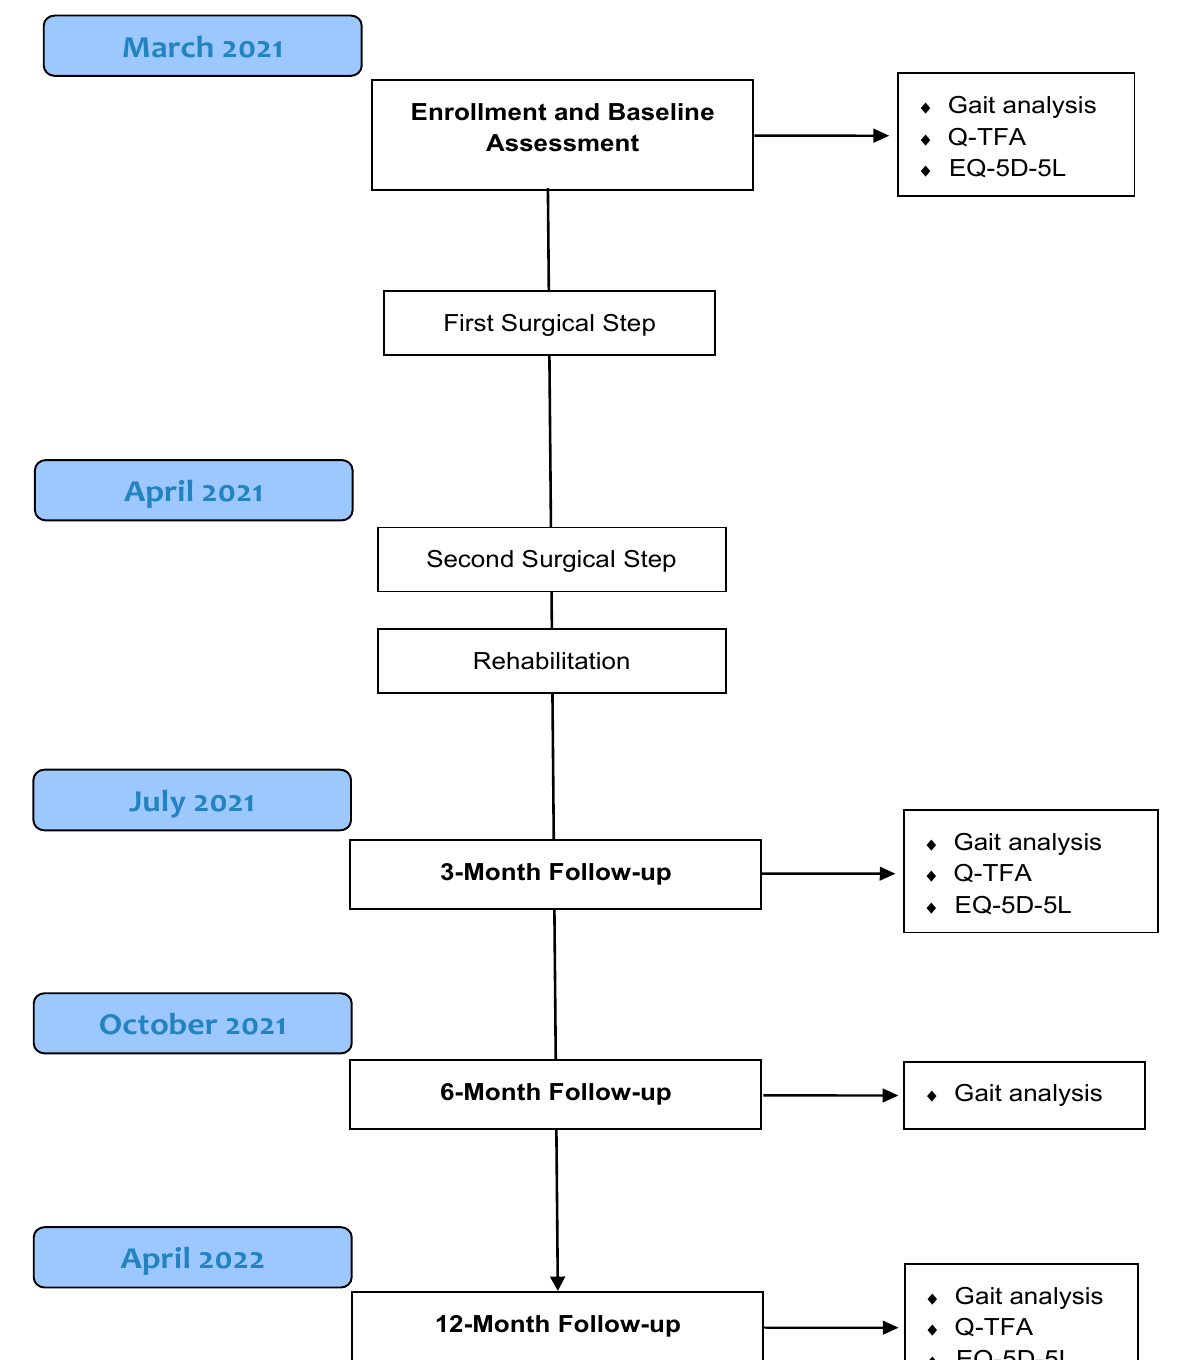
Figure 1. Flow diagram presenting the longitudinal assessment of the transfemoral amputee patient. The surgical procedure is presented in detail in Section 2.2.